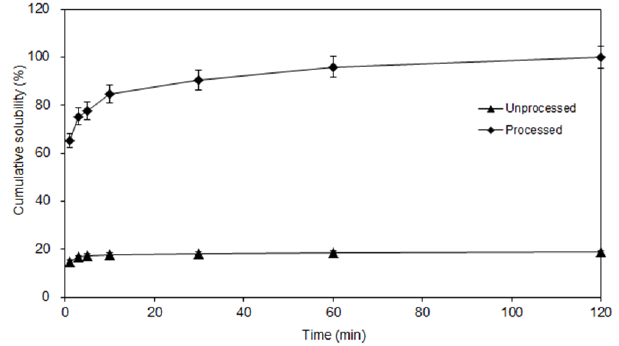
Figure 9. Dissolution profiles of unprocessed and processed spiramycin (spiramycin microparticles are the micronized spiramycin by homogenate ‐ antisolvent precipitation under optimum